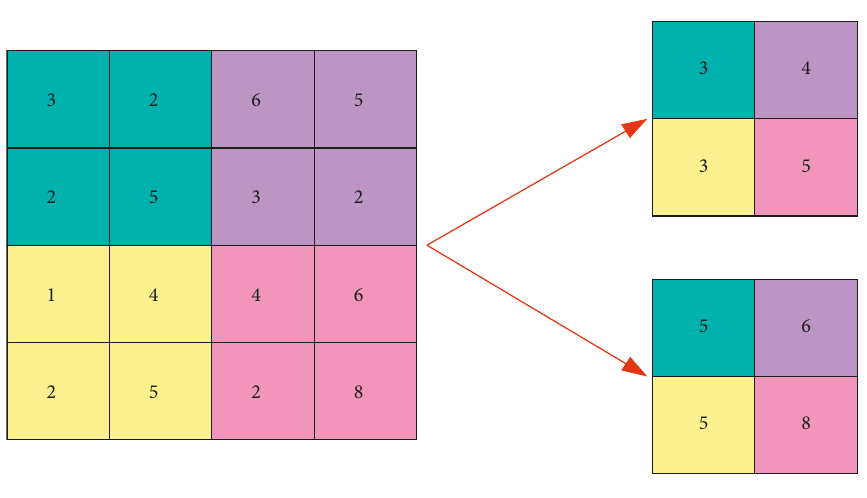
Figure 6: Schematic diagram of pool layer operation type.